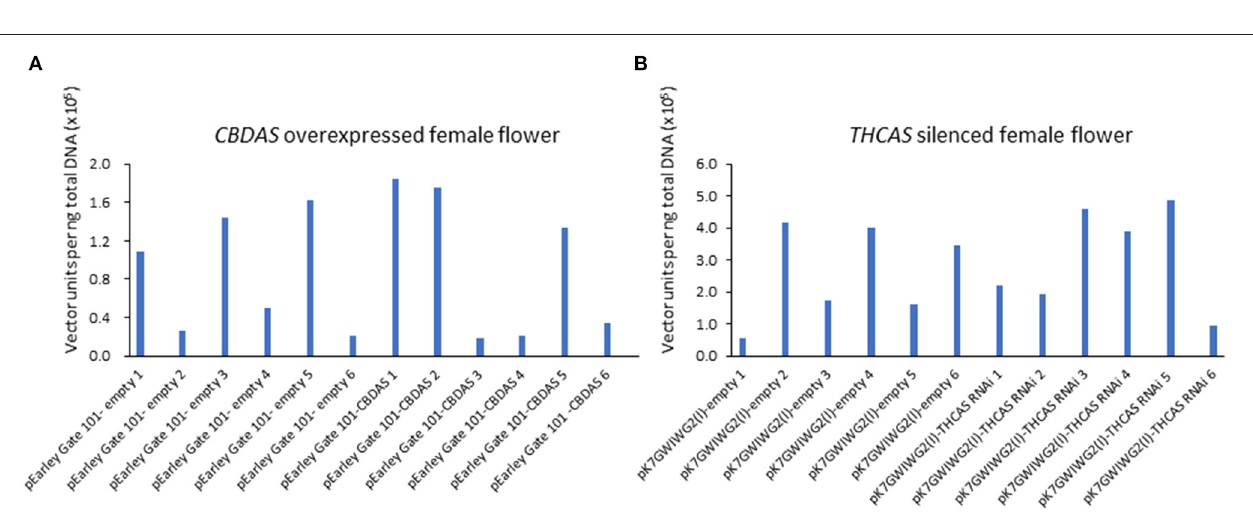
FIGURE 5 | Absolute quantitation of vector units in agroinfiltrated hemp flowers in CBDAS overexpressed female flowers (A) and THCAS silenced female flowers (B) . The vector accumulation was determined by qPCR using a calibration curve.